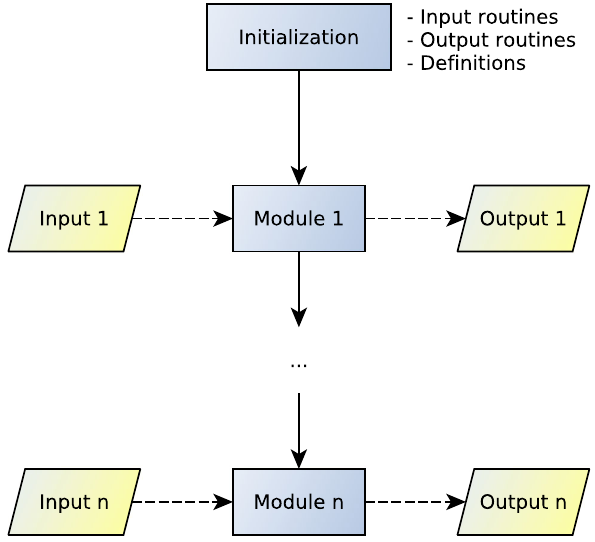
Fig. 1 DsixTools ’ global flowchart. The user can provide input to each module or use the results obtained with the previous